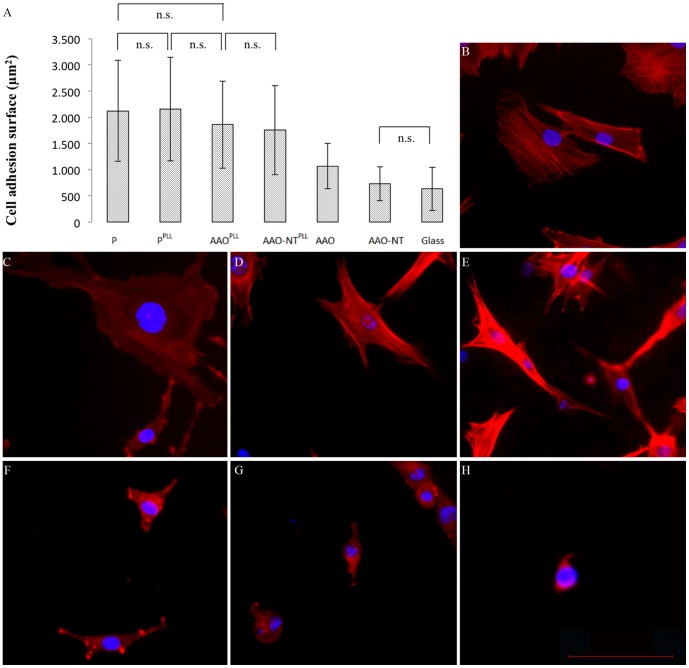
Cell surface area.N = 3. Kruskal-Wallis followed by multicompare analysis, p = 0. Actin (red) and nuclei (blue) staining on P, PPLL, AAOPLL, AAO-NTPLL, AAO, AAO-NT and glass, respectively (B–H). Scale bar: 100 µm.